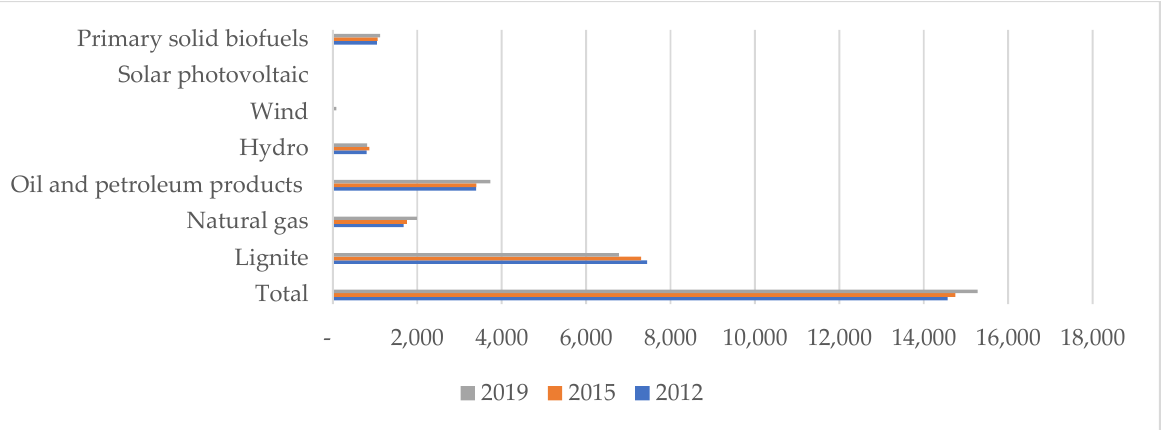
Figure 6. Serbian energy supply in 2012, 2015, and 2019 in thousands of tonnes of oil equivalent: total supply and major fuels [98].